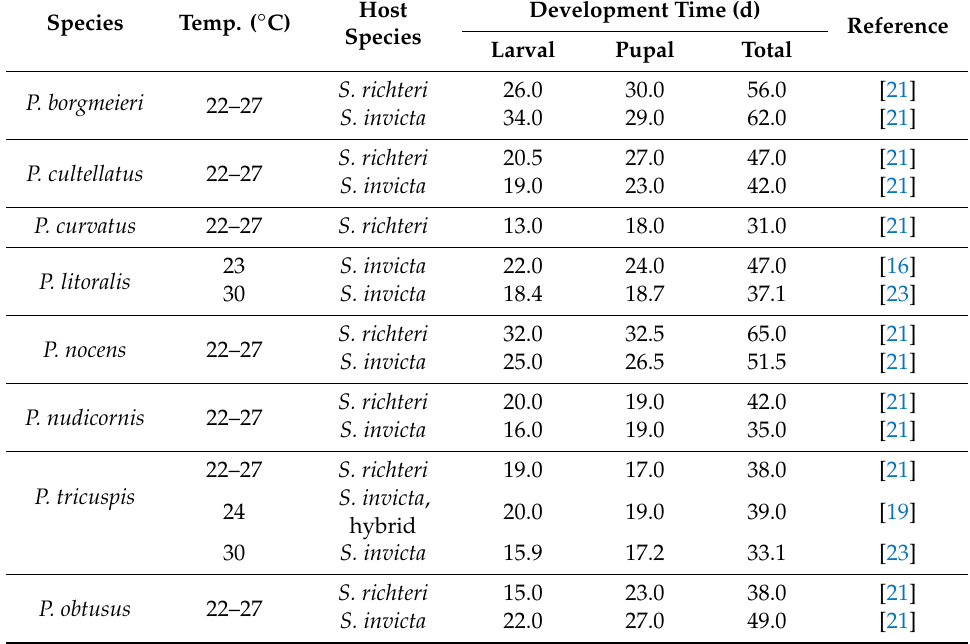
Table 1. Mean egg-larval, pupal, and total development times for female Pseudacteon flies reared on the imported Solenopsis fire ants at various